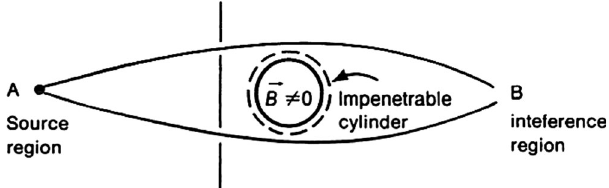
FIG. 1. Double-slit experiment illustrating the AB effect. Given the possible electron paths from source at A to detector at B , the resulting interference pattern changes as the B in the impen- etrable cylinder is turned on or off. Figure reproduced from J. J. Sakurai ’ s Modern Quantum Mechanics